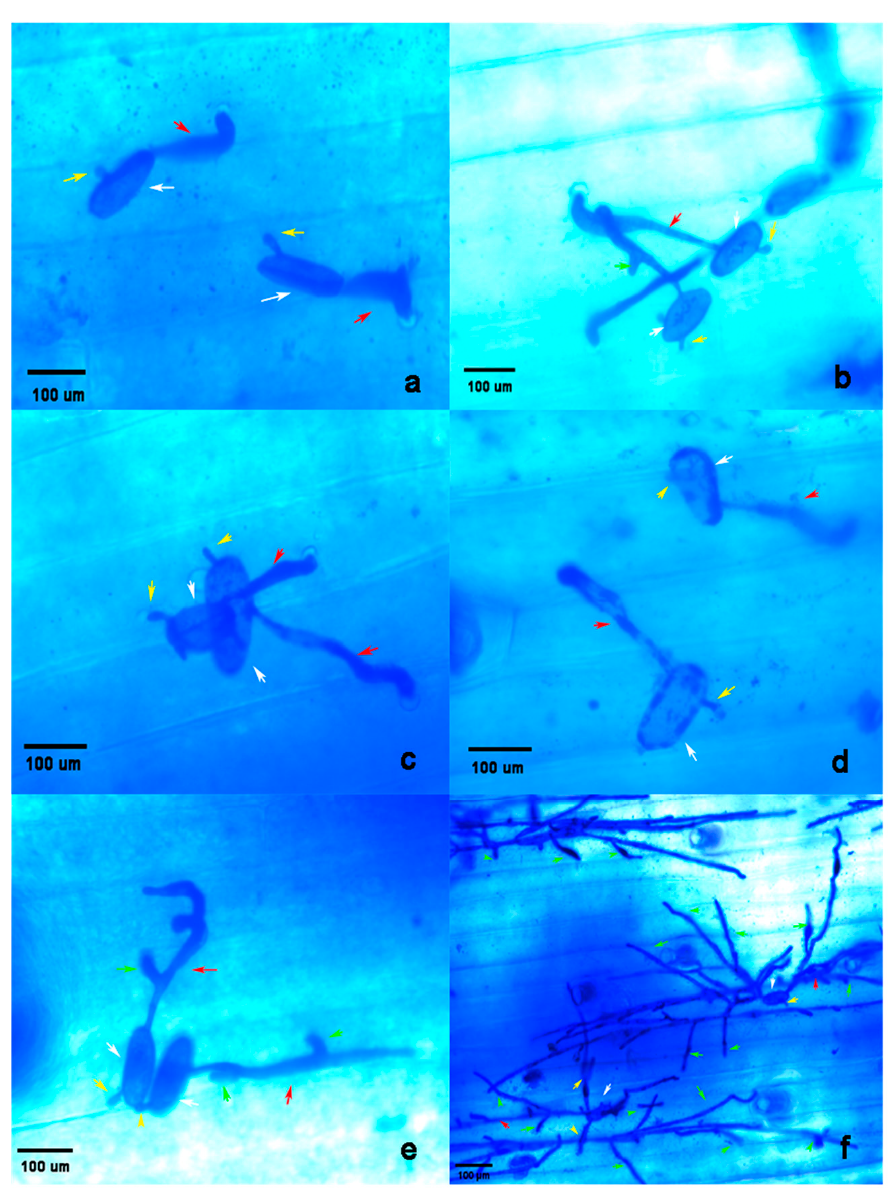
Figure 7. Developmental states of the conidiospores 25 h and 72 h after inoculation on leaves of the translocation lines. ( a ) Spores 25 h after inoculation on leaves of the translocation lines A303. ( b ) Spores 72 h after inoculation on leaves of the translocation lines A303. ( c ) Spores 25 h after inoculation on leaves of the translocation lines B303. ( d ) Spores 72 h after inoculation on leaves of the translocation lines B303. ( e ) Spores 25 h after inoculation on leaves of Wan7107. ( f ) Spores 72 h after inoculation on leaves of Wan7107. White arrows point to spores, yellow arrows point to primary germinal tubes, red arrows point to appressorium, and green arrows point to secondary hyphae.